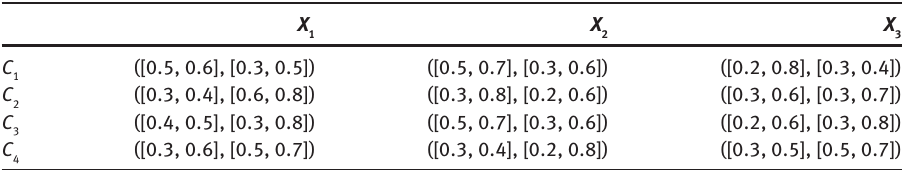
Table 3: Interval-Valued Pythagorean Fuzzy Decision Matrix of D 3 .